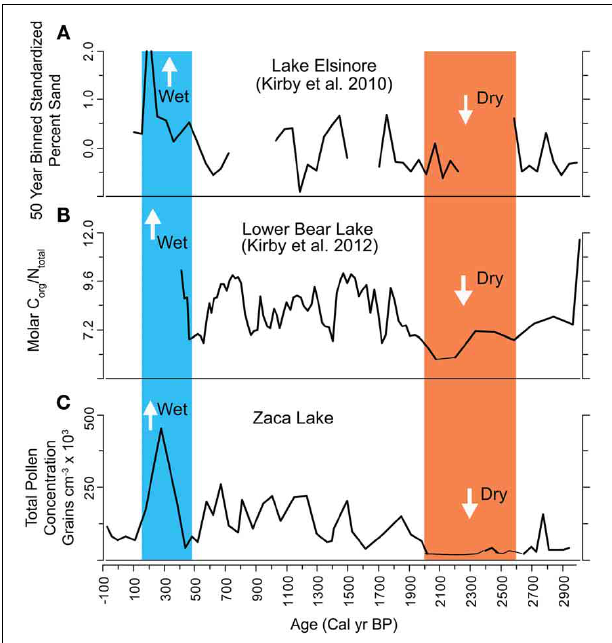
FIGURE 9 | Comparison between Zaca Lake and two other records from Southern California. Red band represents 2700–2000 cal yr BP dry period identified in the Zaca Lake record. Blue band represents Little Ice Age wet period. Data include (A) 50 year binned standardized % sand from Lake Elsinore (Kirby et al., 2010). High sand values indicate periods of increased runoff. (B) Molar C/N from Lower Bear Lake (Kirby et al., 2012). Higher values indicate periods of increased runoff and elevated lake levels. (C) Overall pollen concentration from Zaca Lake (this